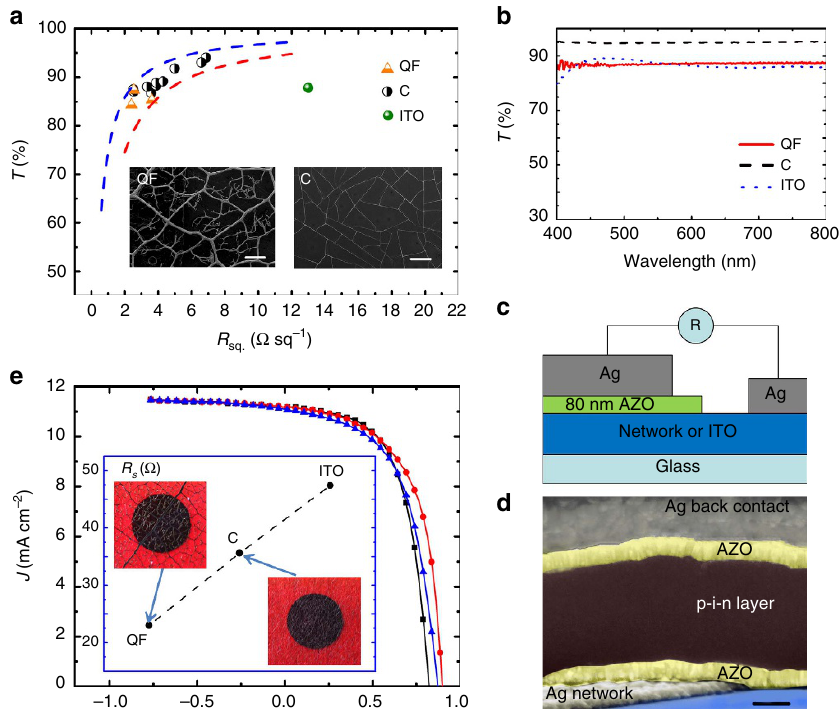
Figure 1 | Optoelectronic performance and morphology of the networks and ITO films. ( a ) T versus R sq ; T is measured at 550nm vacuum wavelength. The expected analytical dependencies (equation (8)) for two figures of merit F ¼ 1,200 and 700 are shown as the blue and red dashed lines, respectively. The left inset shows the SEM image of the QF network based on the leaf venation (scale bar, 500 m m), and the right inset is the SEM image of the C network (scale bar, 100 m m). ( b ) T versus wavelength for QF, C and ITO films. ( c ) Schematic of the contact resistance measurement. ( d ) SEM image of the cross-section of the PVcell. The scale bar is 200 m m. ( e ) I – V characteristics of the PVcells under AM1.5 illumination: QF (red line with circles); C (black line with squares); and ITO (blue line with triangles). The inset shows a plot of the corresponding series resistance R s . Two optical images of the PV cells are also shown in this inset; the cell based on the QF network has a clearly visible leaf venation structure. The dark circle (0.196cm 2 ) in the middle of each cell is the Ag back